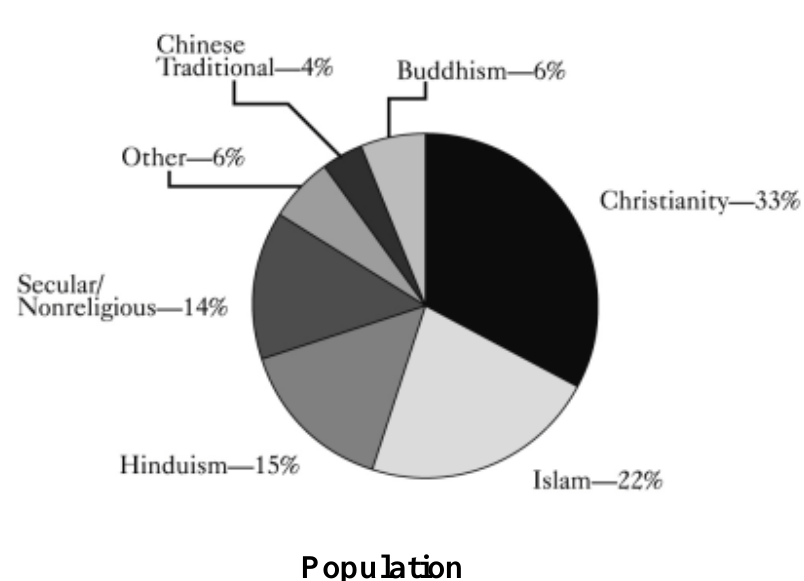
Figure 1. The Major Religions of the World as a Percentage of World